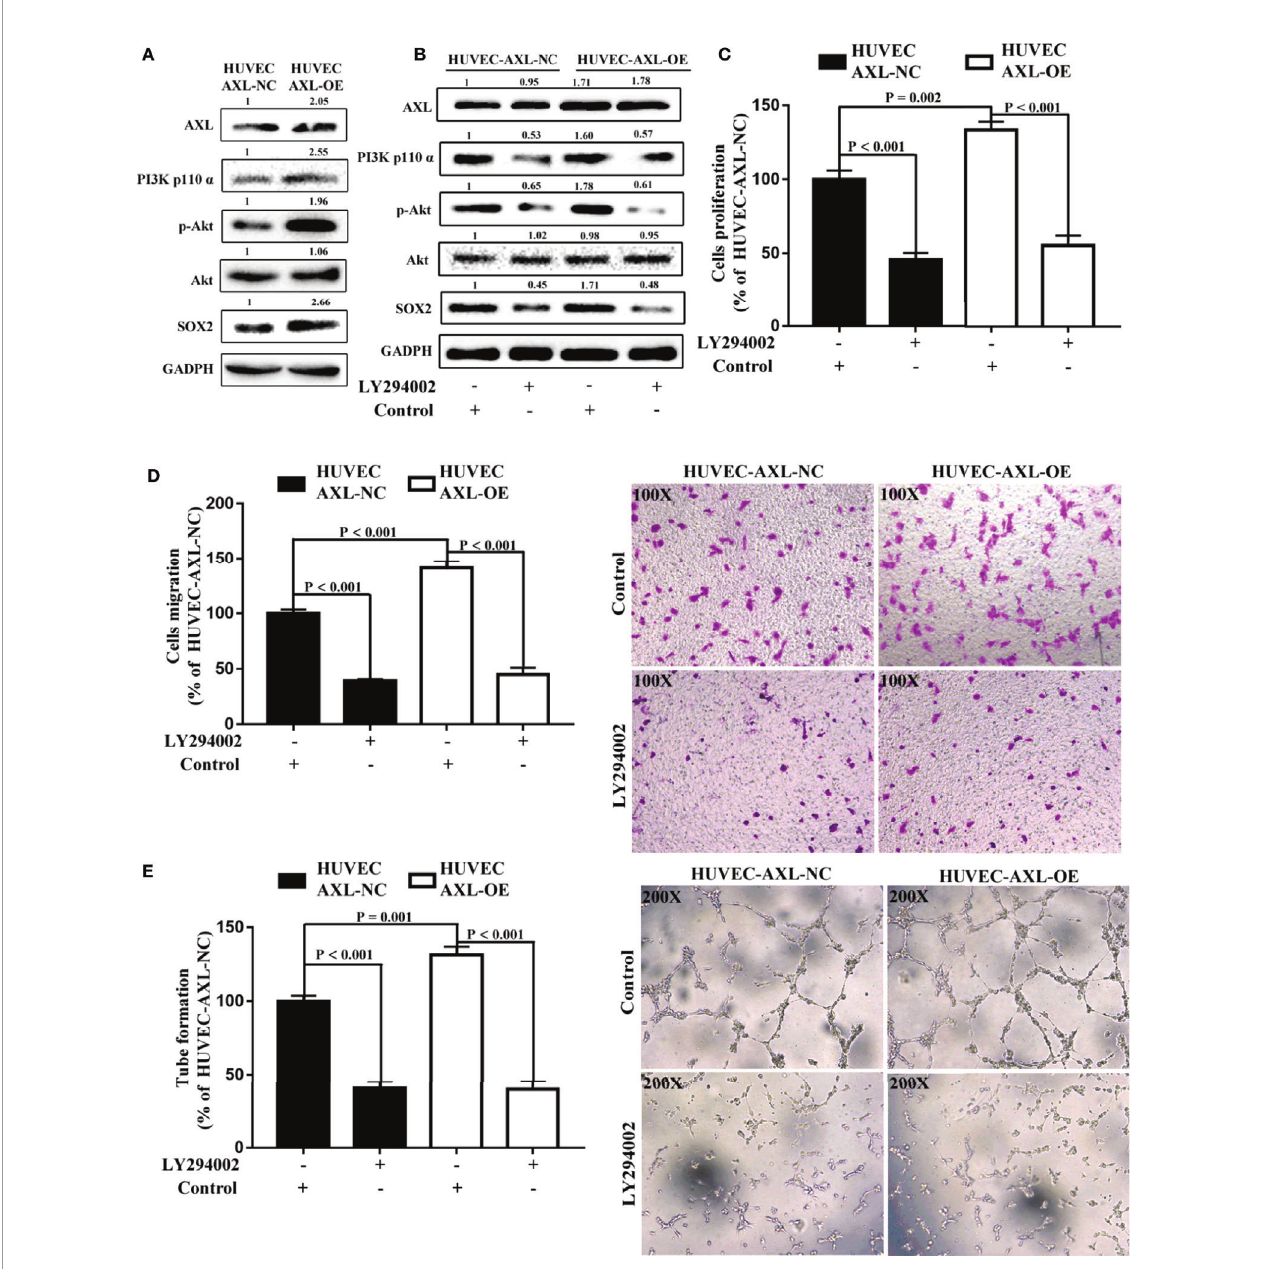
FIGURE 6 | AXL/SOX2/DKK-1 axis modulates the cell migration and tube formation of HUVECs through overactivation of the PI3K/AKT signaling pathway. (A) The expression levels of the PI3K/AKT signaling pathway were higher in HUVEC-AXL-OE cells compared with HUVEC-AXL-NC cells. (B) LY29400 downregulated the expression levels of the PI3K/AKT signaling pathway in HUVEC-AXL-NC and HUVEC-AXL-OE cells. (C – E) LY294002 inhibited cell proliferation (NC: p < 0.001; OE: p < 0.001), migration (HUVEC-AXL-NC: p < 0.001; HUVEC-AXL-OE: p < 0.001), and tube formation (HUVEC-AXL-NC: p < 0.001; HUVEC-AXL-OE: p <